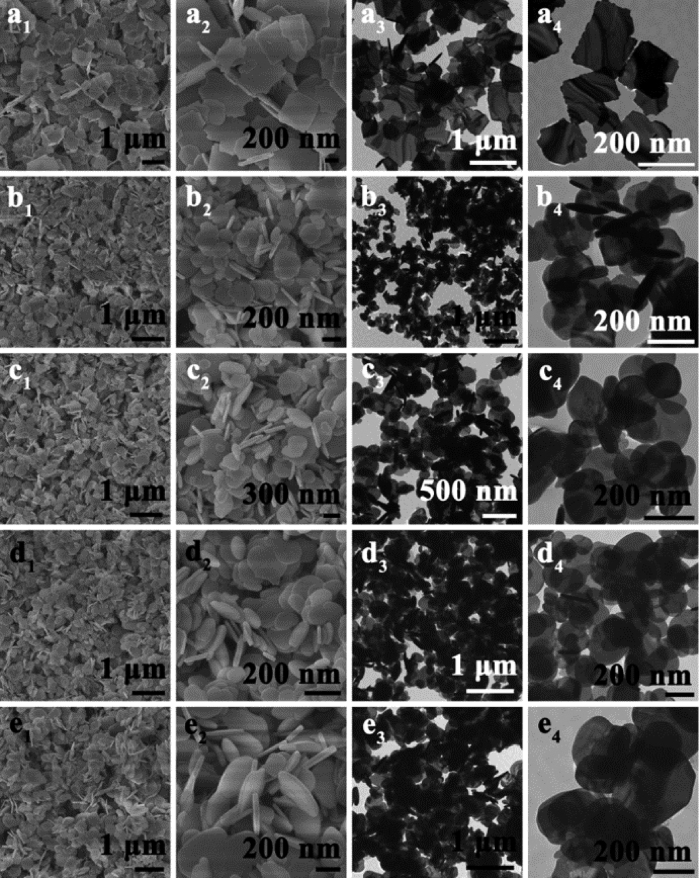
SEM and TEM images of BiOBrxI1−x nanoplates with different values of x: (a1–a4) 1.0, (b1–b4) 0.8, (c1–c4) 0.5, (d1–d4) 0.2, and (e1–e4) 0.